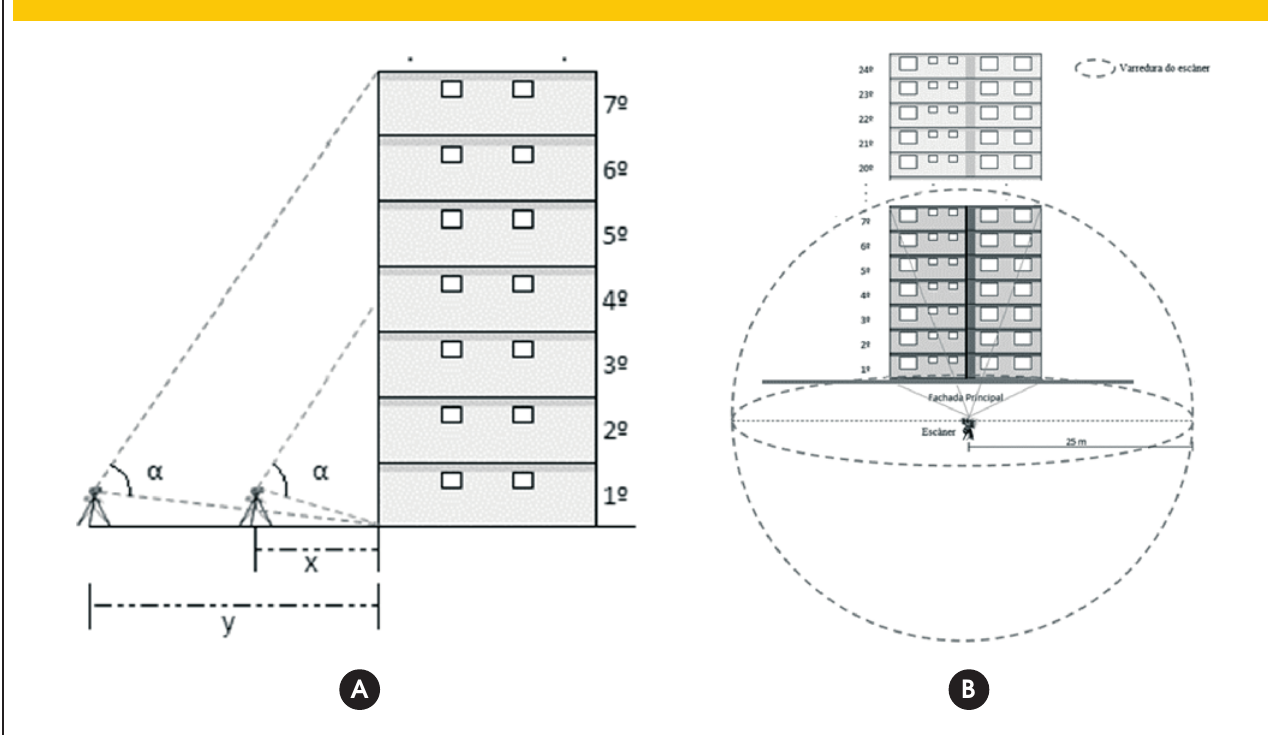
Figure 5 – (a) Schematic representation of the distance of the scanner in relation to the facade; (b) Schematic representation of the scanning area of the facade in relation to the capacity of the scanner and scanning volume within a 25 meter